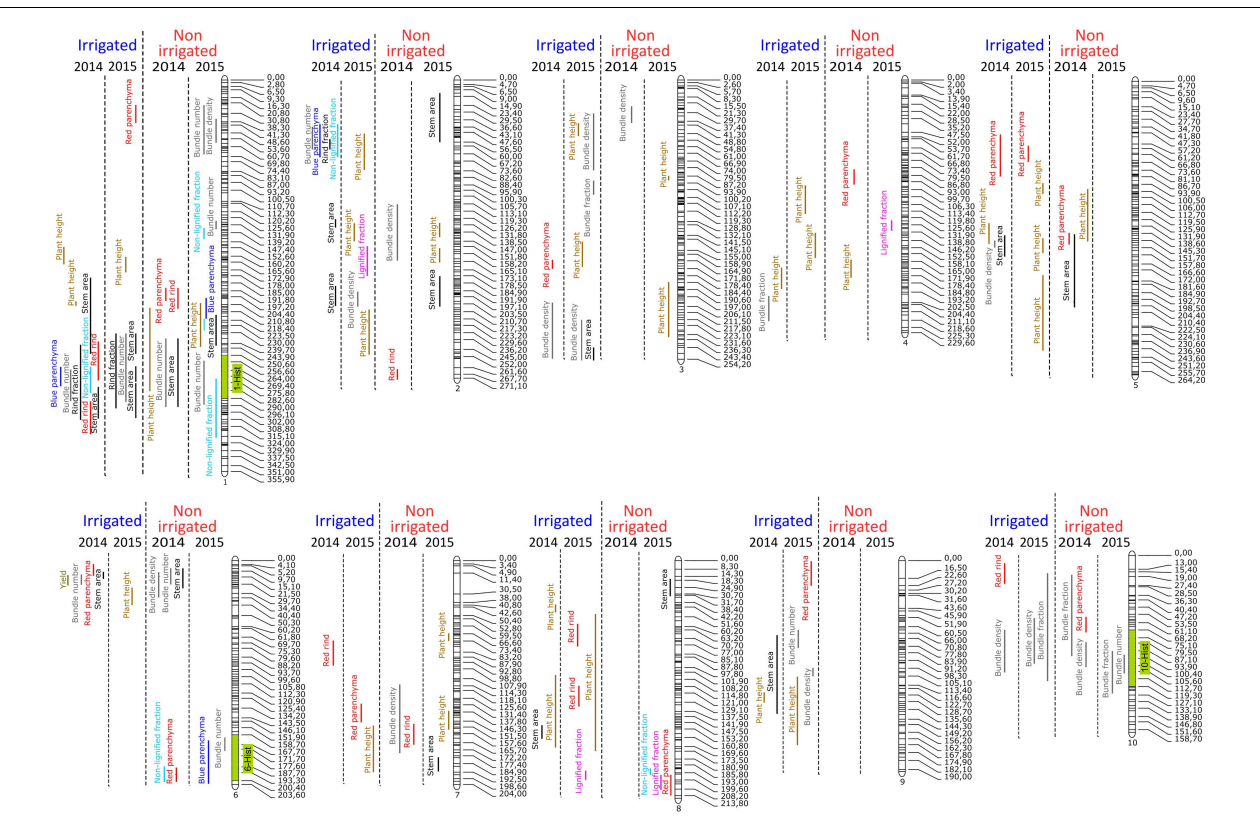
FIGURE 3 | Mapping of QTL involved in the variations of histological and agronomical traits on the 10 chromosomes of maize for the four conditions: 2014 irrigated, 2015 irrigated, 2014 non-irrigated, and 2015